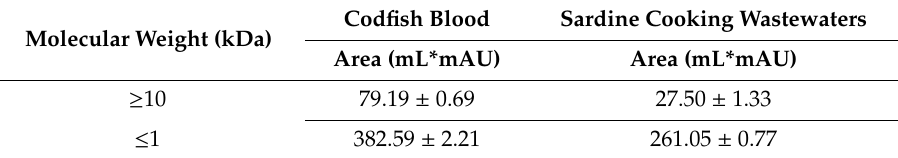
Table 3. FPLC chromatogram area of the di ff erent peaks from the pre-treated codfish blood and sardine cooking wastewaters (raw materials). The results are given in